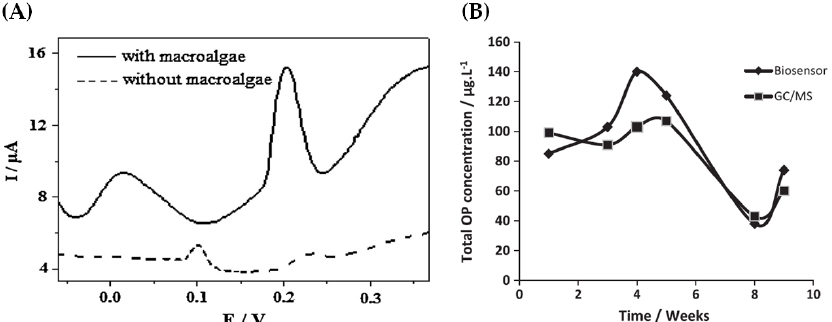
Figure 2. ( A ) current results of biosensor with and without macroalgae; and ( B ) total concentration of methyl parathion obtained using the biosensor and SPME-GC/MS over 10 weeks in the same collecting point on a Brazilian lake (Reprinted from Nunes et al. [14], Copyright (2014), with permission from Elsevier).